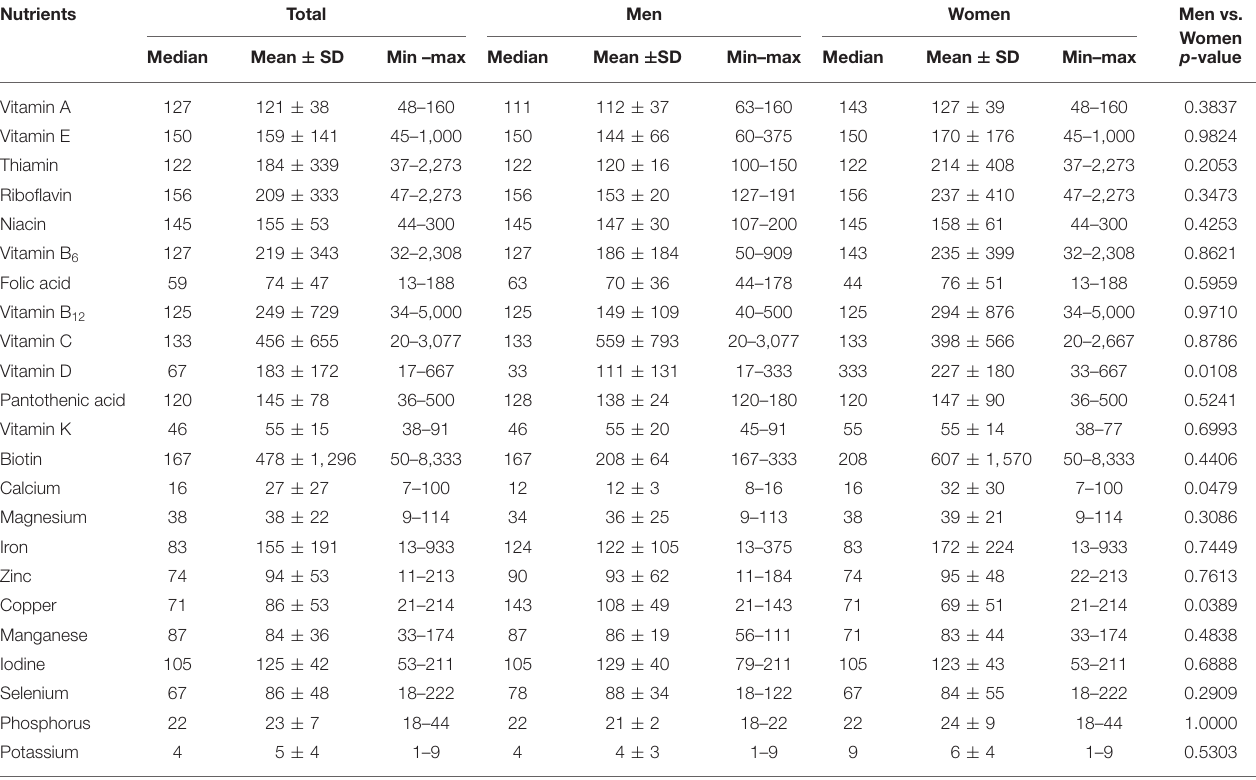
TABLE 5 | Percentage of EAR or AI which was the intake of vitamins and minerals from food